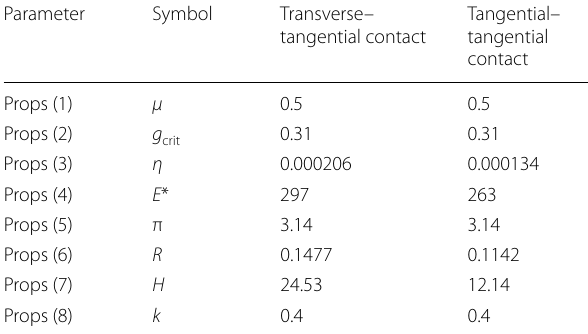
g crit is the abbreviation of the elastic slip deformation [45]; Props stands for the abbreviation of property in the normal contact model subroutine; Props (1)–(8) are the 8 parameters in the normal contact model subroutine, respectively